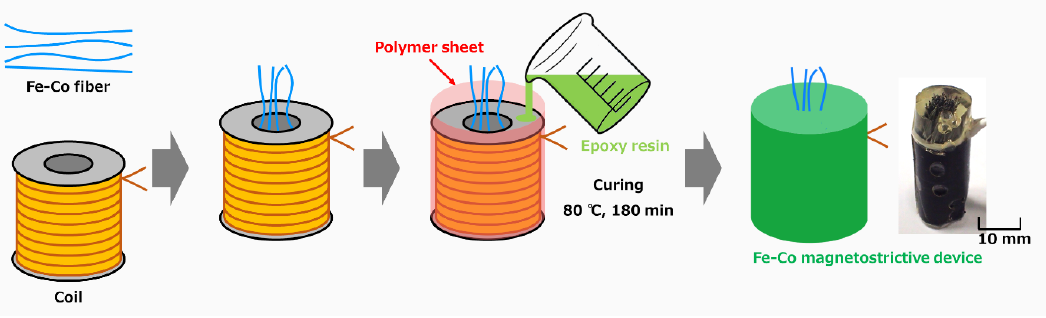
Figure 1. Schematic illustration of the preparation process of Fe–Co magnetostrictive device.